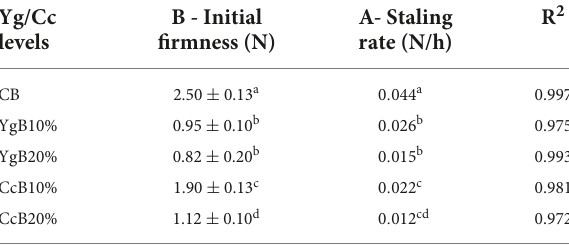
TABLE 3 Bread stalling parameters: A- bread staling rate (N/h) and B- bread firmness (N), obtained for control bread (CB) and breads with different levels of Yg and Cc tested (YgB, CcB)*.